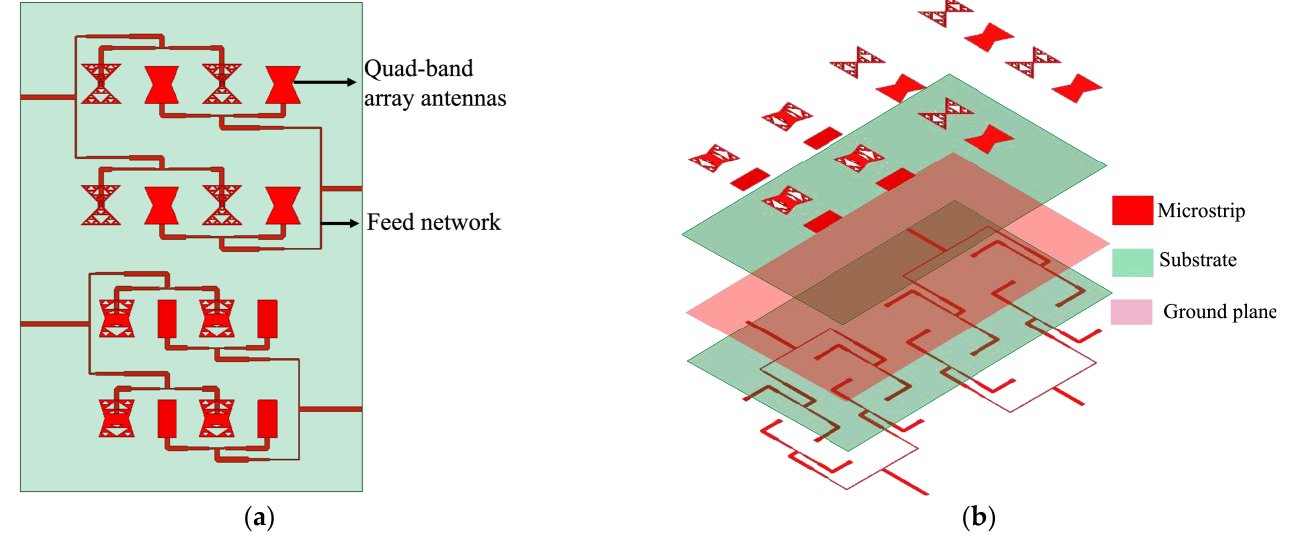
Figure 1. Schematic description of quad-band array antenna: ( a ) top view of radiating elements including feed network on bottom layer; ( b ) exploded view of the antenna.